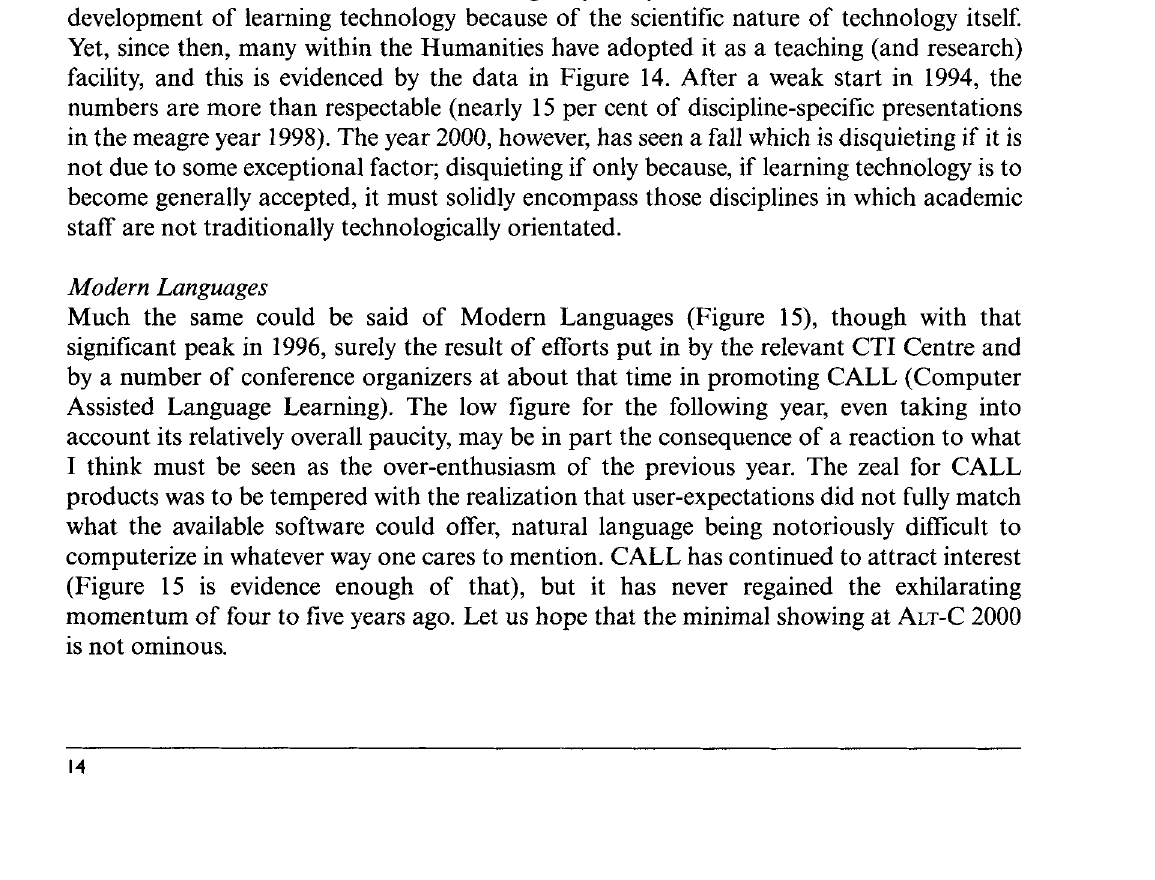
Figure 14: Data for